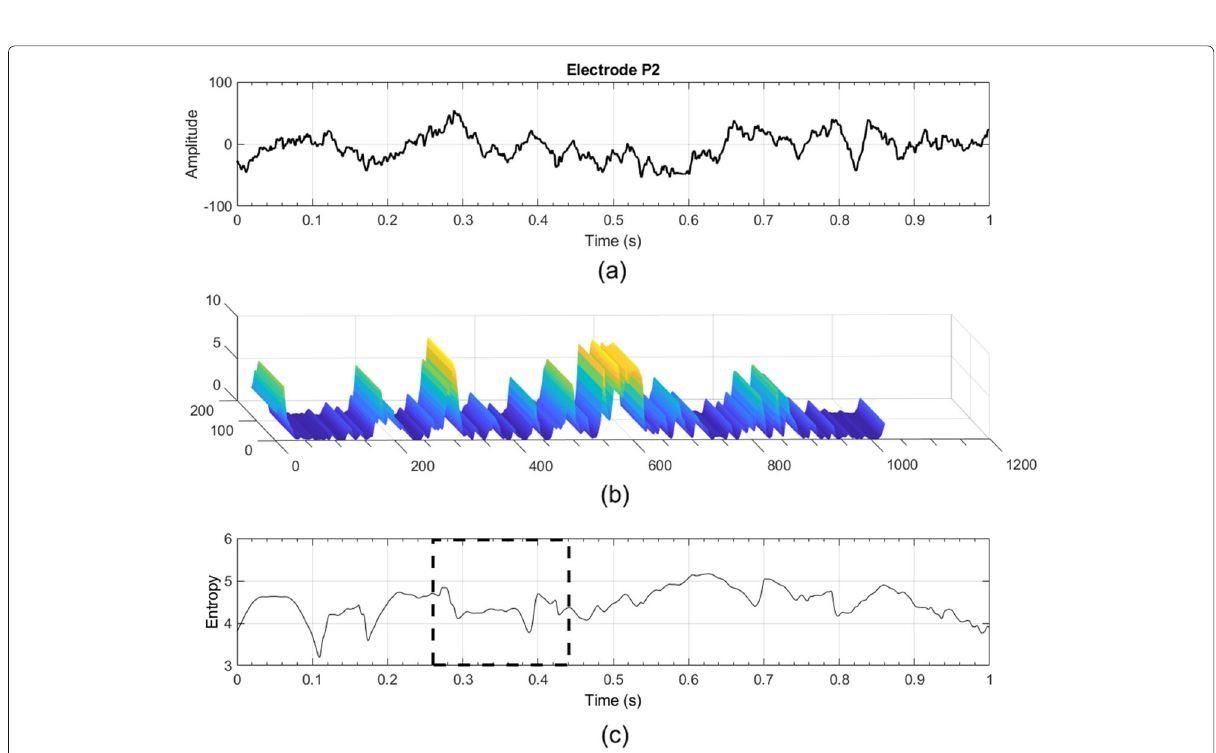
Fig. 18 Electrode P2 after RICI. a Time domain representation of ERP. b SPWVD time-frequency representation. c Short-term Rényi entropy of the